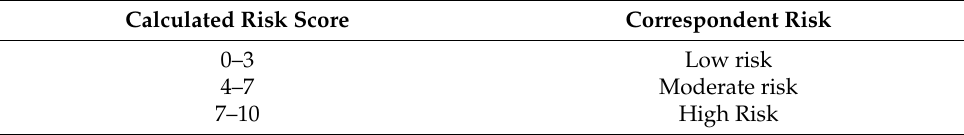
Table 1. Risk of bias scale of included